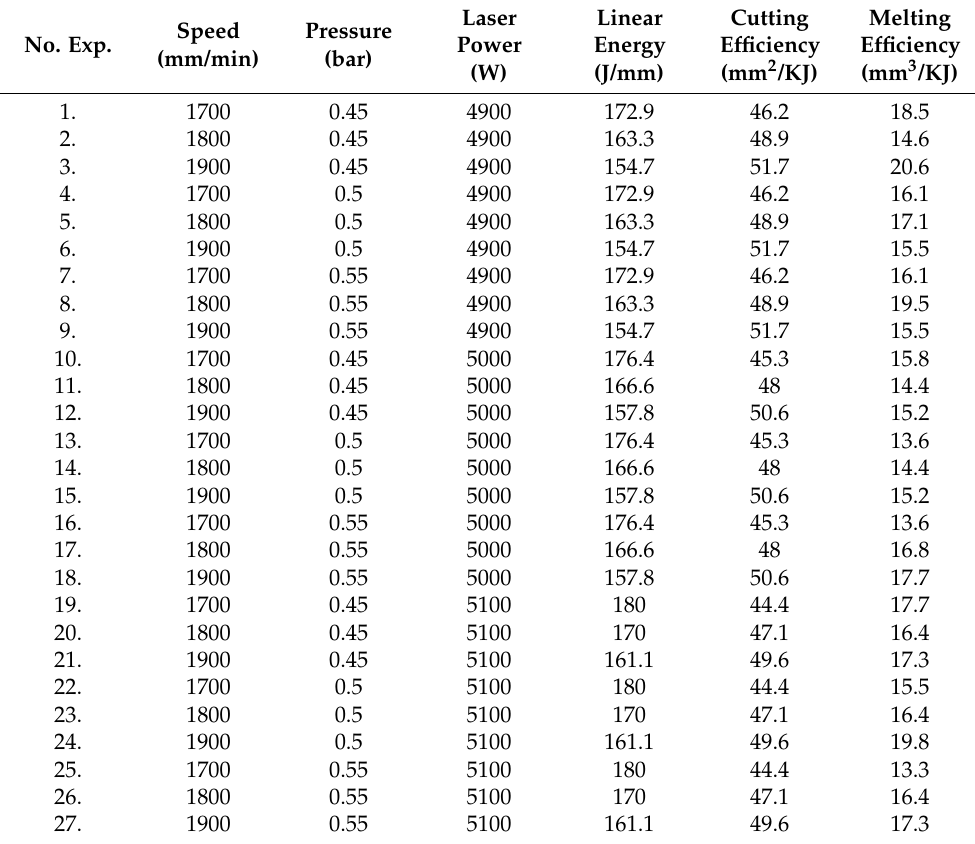
Table 3. Design of experiment. Measured values of output responses.